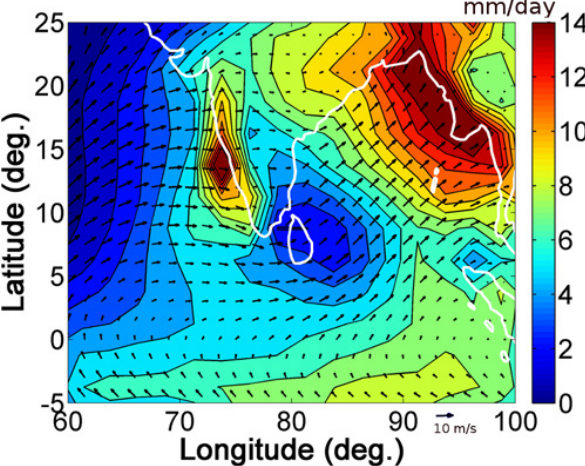
Fig. 3. Long-term (1996–2009) seasonal mean regional distribution of precipitation rate (mmday − 1 ) during ASM. The vectors repre- sent the corresponding long-term seasonal mean winds at 1000hpa level during this